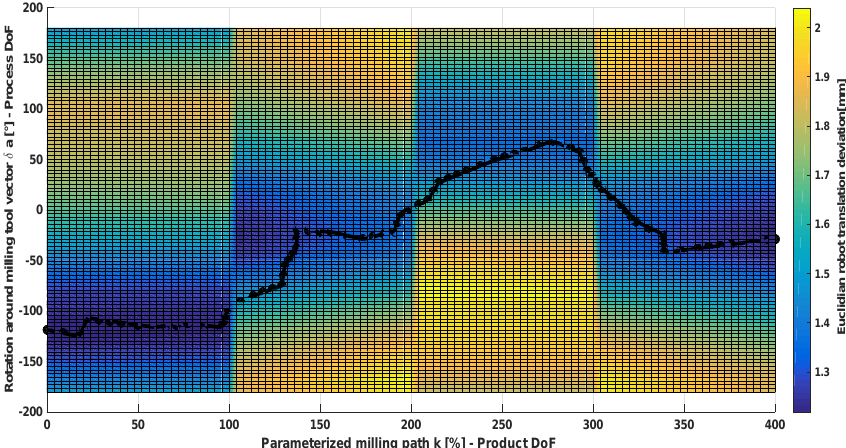
Figure 11. RMP C-space for the four paths with its state cost (Euclidean robot translation deviations) and a computed optimal path using the T-RRT